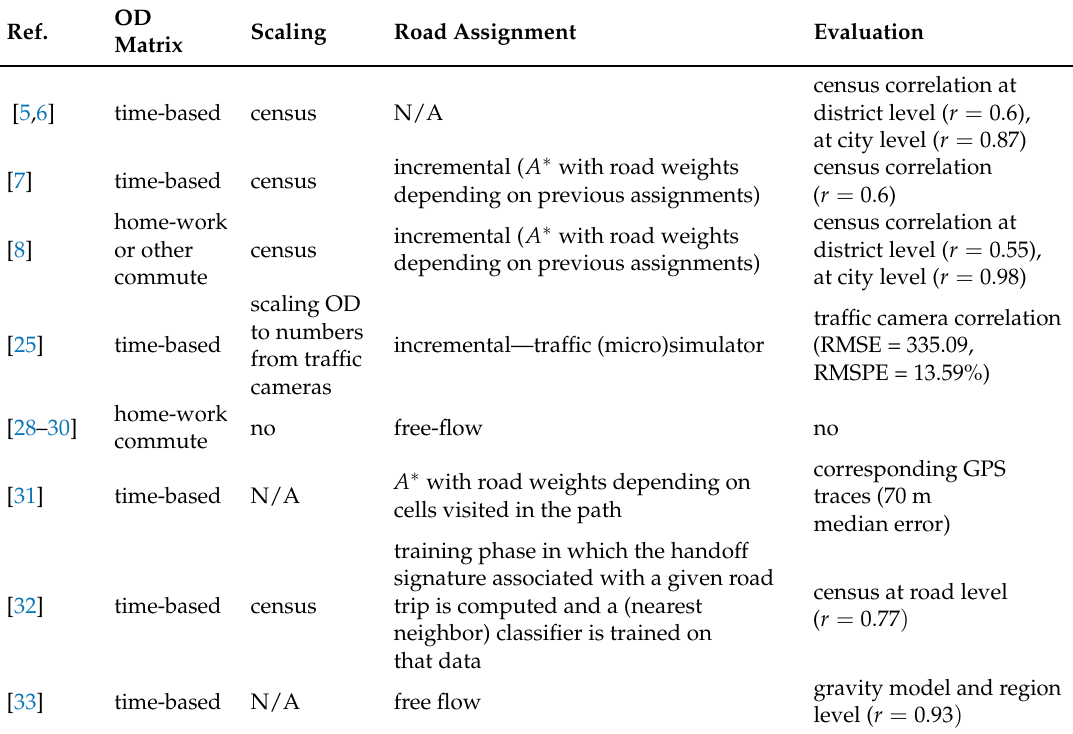
Table 1. State of the art in OD matrices estimation from call detail records (CDR) and GPS data.